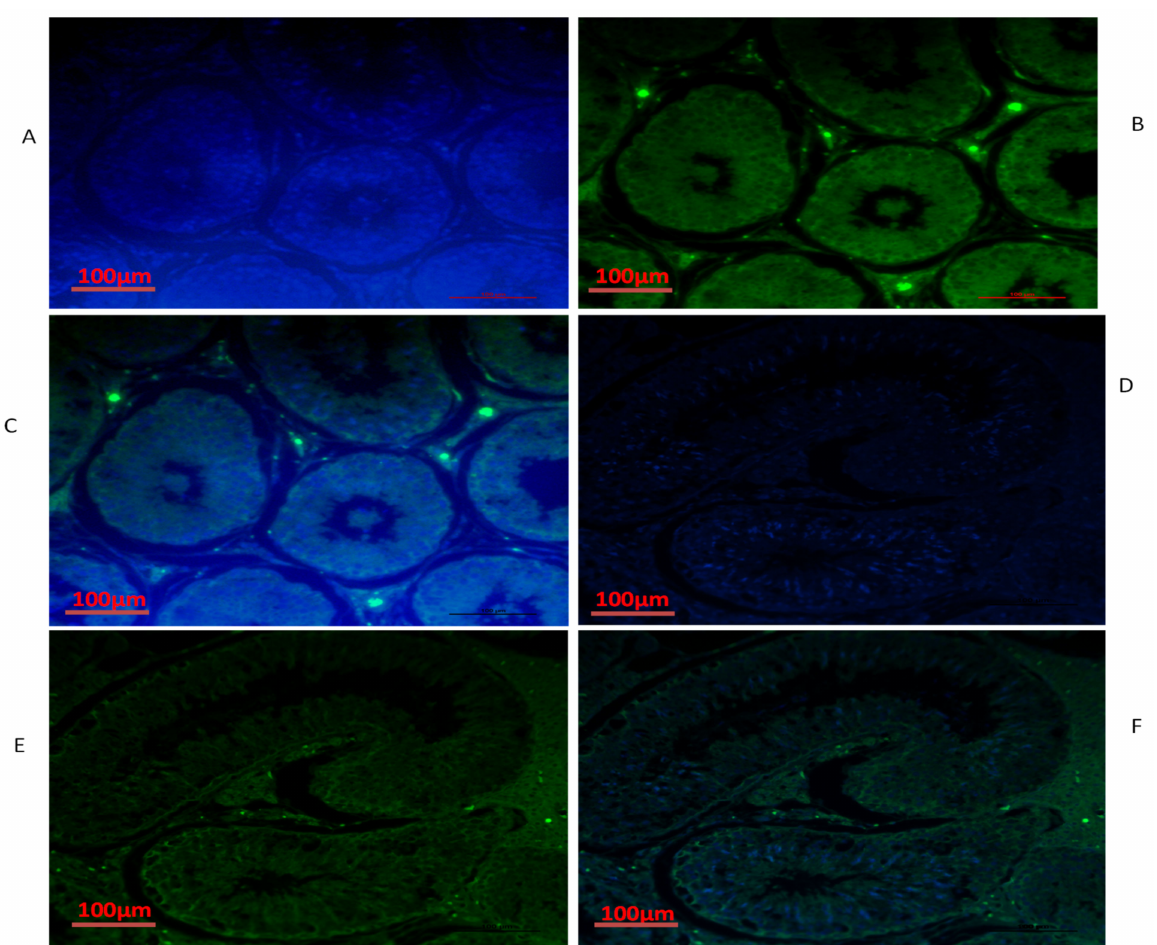
Figure 7. Immunofluorescence localization of BOLL protein in the testes of yaks under different feeding conditions: ( A – C ) natural grazing without concentrate supplementation; ( D – F ) natural grazing plus concentrate supplementation. Scale bar = 100 µ m ( A – F